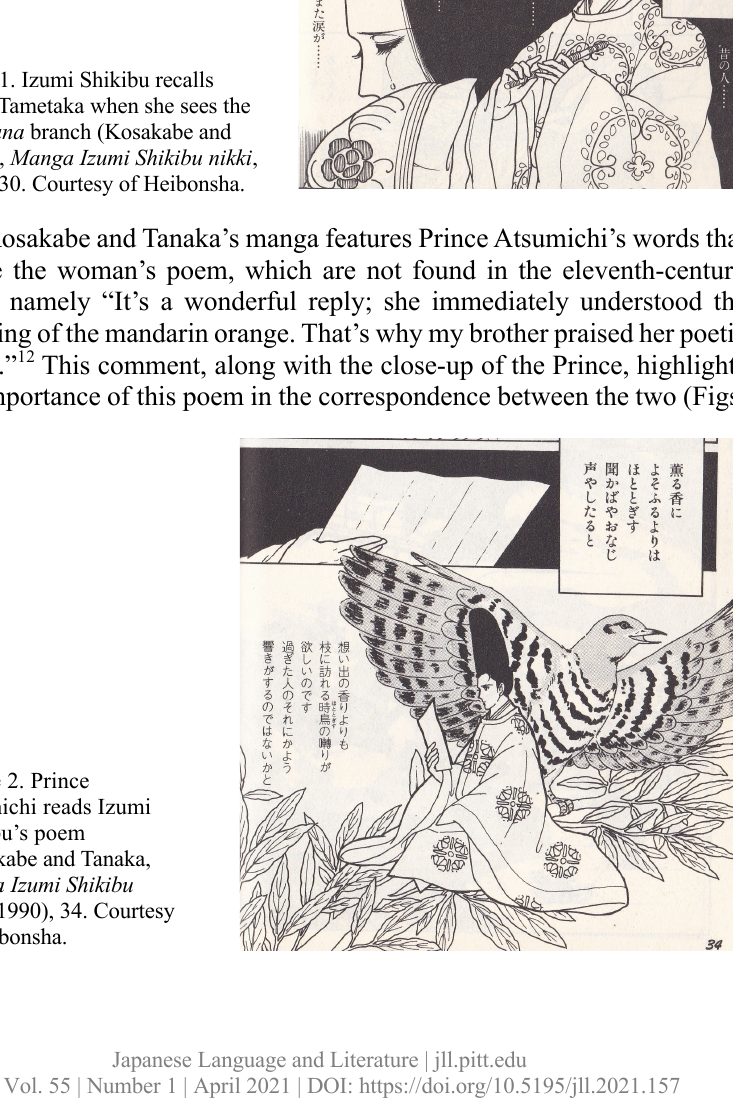
Figure 1. Izumi Shikibu recalls